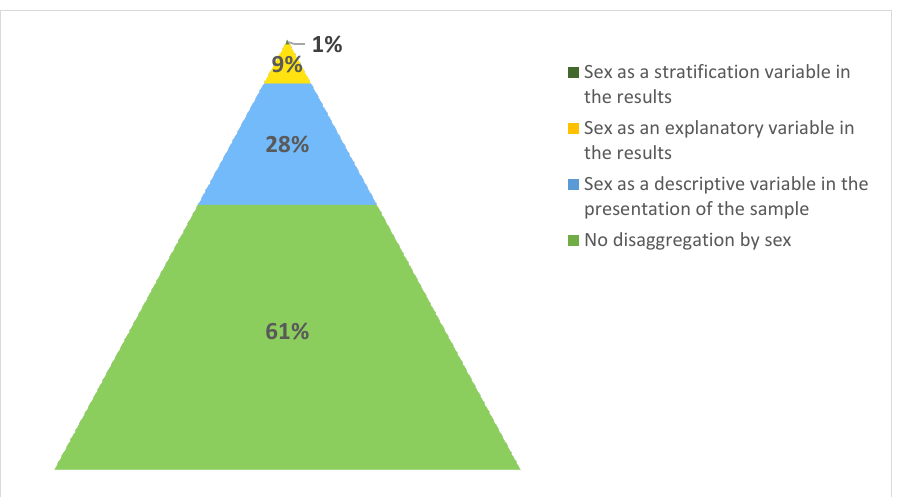
Figure 1. Evolution over time of the female/male (F/M) author ratio for total authors, first authors